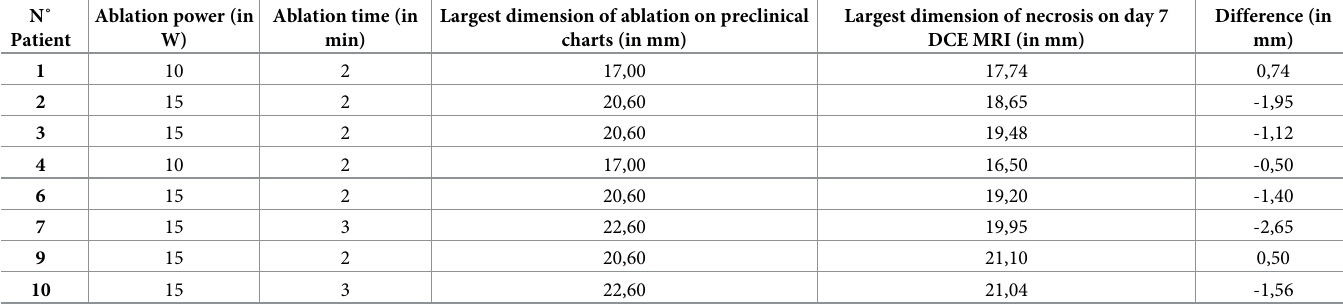
Table 2. Compares the largest dimension of necrosis to that of preclinical ablation charts. N˚ Ablation power (in Patient W)